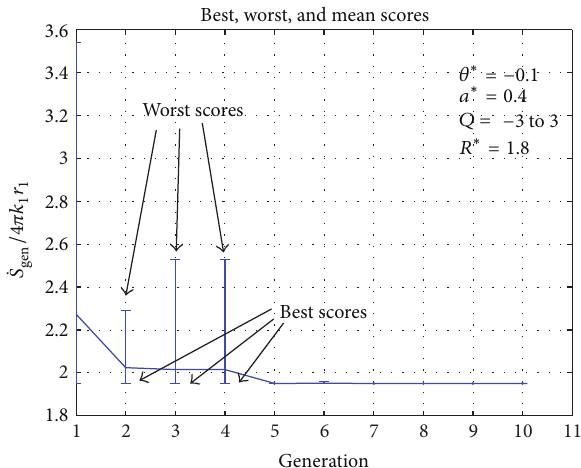
Figure 6: Best, worst, and mean values of fitness function ( hollow sphere.